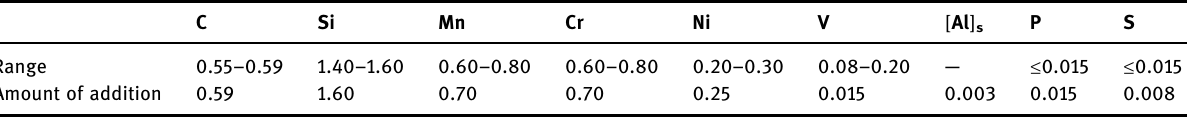
Table 2: Standard composition of 55SiCr suspension spring steel ( wt% ) C